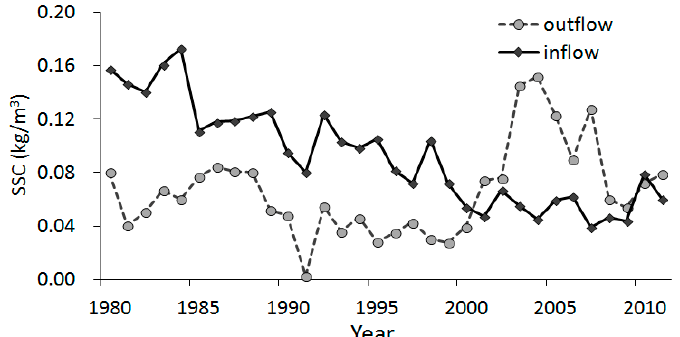
Figure 8. Variation of annual average suspended sediment content (SSC) of lake inflow and outflow during 1980–2011.